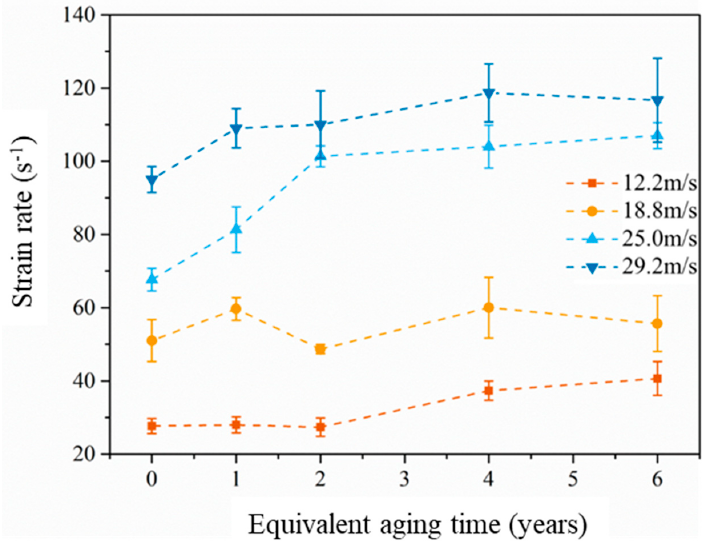
Figure 10. Strain rate-equivalent aging time curves with different impact velocities. Table 4. The strain rate under different impact velocity and equivalent aging time.